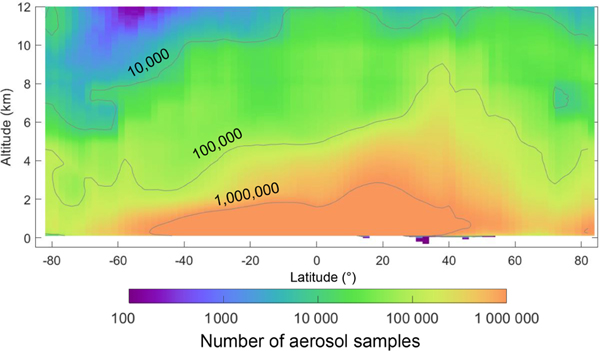
Zonal total number of aerosol samples reported by the level 3 product prior to quality screening for 2007–2016 at night, all-sky.